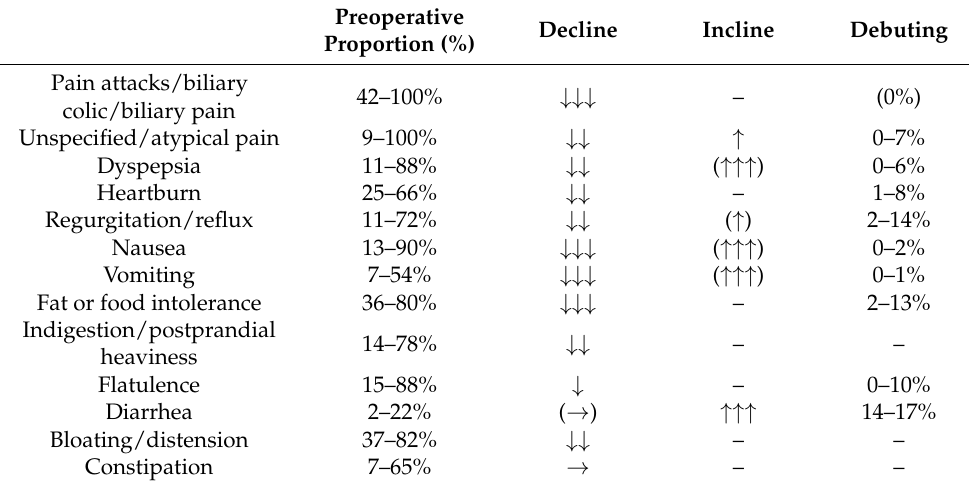
Table 3. Symptomatic outcome following cholecystectomy in prospective